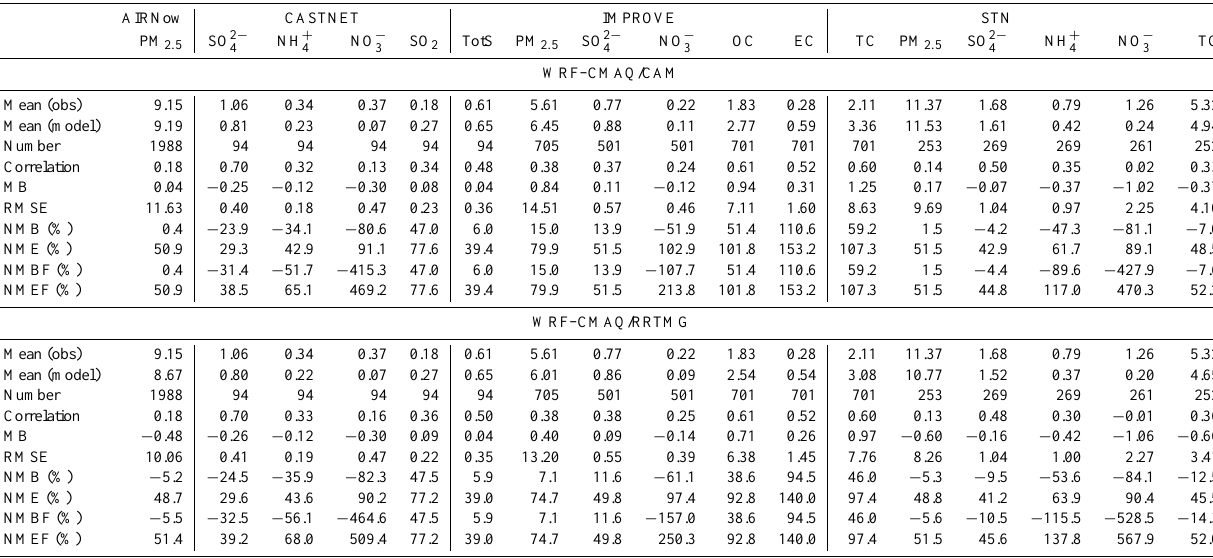
Table 5b. The same as Table 5a, but for PM 2 . 5 and its components for each network over the western United States (longitude less than − 100 ◦ ) for August of 2006 ∗